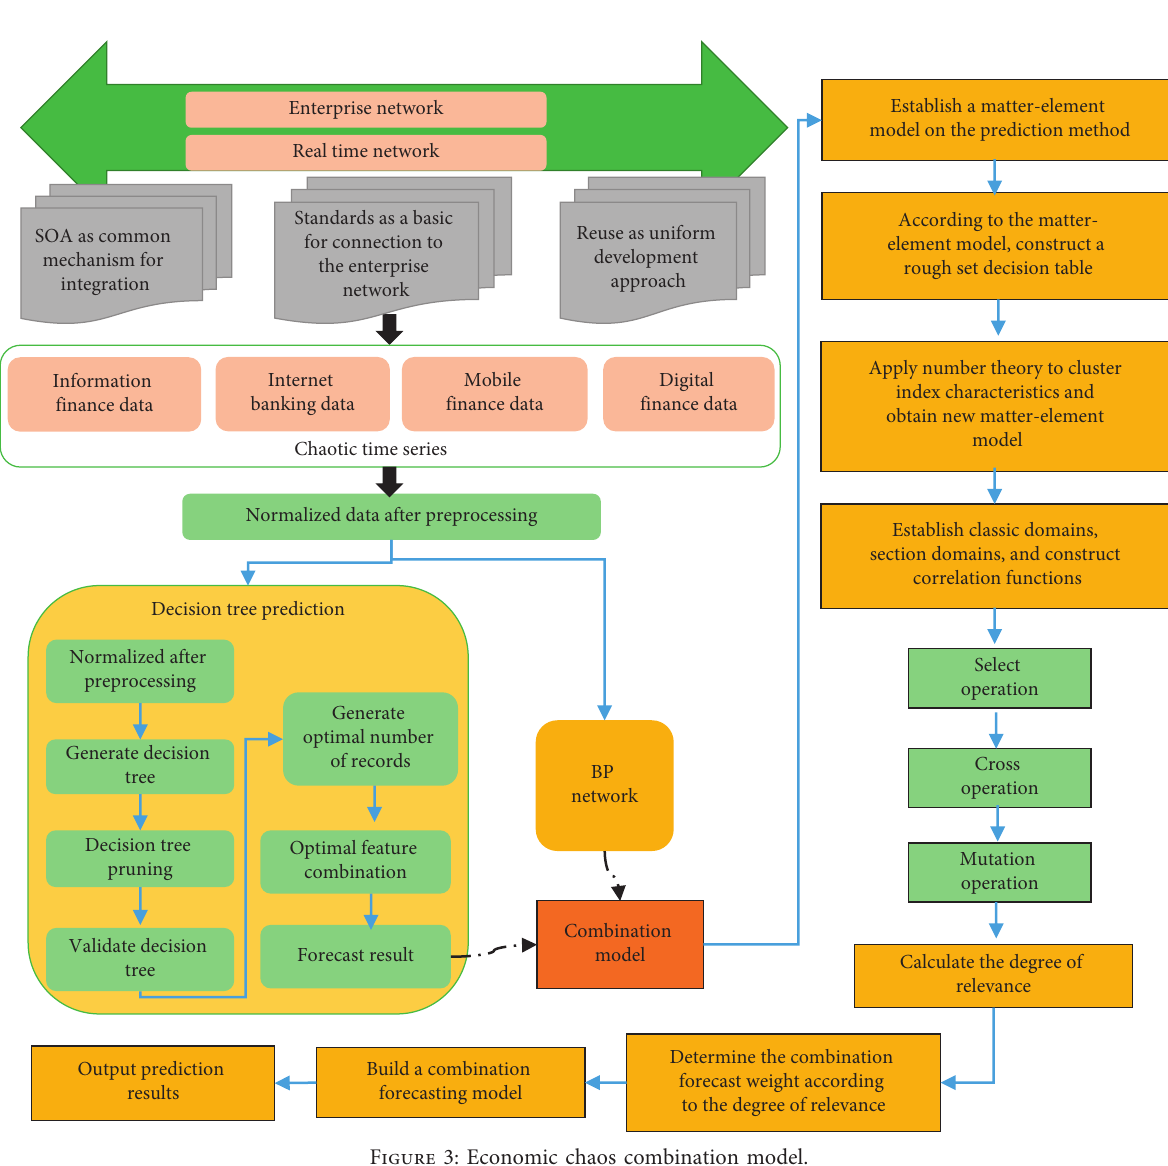
Figure 3: Economic chaos combination model.